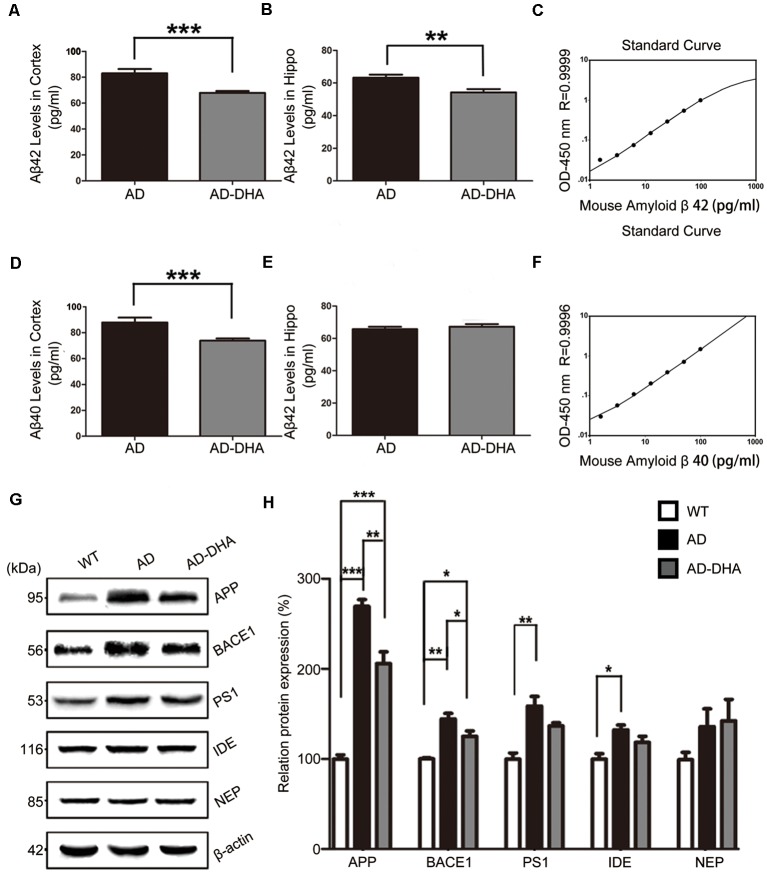
Effects of DHA on eliminating Aβ40, Aβ42, APP, and β-site APP cleaving enzyme (BACE1). Protein levels of Aβ40 and Aβ42 in the hippocampus and cortex were detected by ELISA (A–F). **p < 0.01 and ***p < 0.001 compared to the DMSO-treated AD group. Protein levels of APP, BACE1, PS1, insulin-degrading enzyme (IDE) and NEP in extracts of whole brain tissue were detected by Western blotting (WB), shown in panel (G). Quantification of the WB results are shown in panel (H), and the results are shown as the mean values ± SD. *p < 0.05, **p < 0.01, and ***p < 0.001 between two groups. One-way analysis of variance/Newman–Keuls test was performed for all WB data.